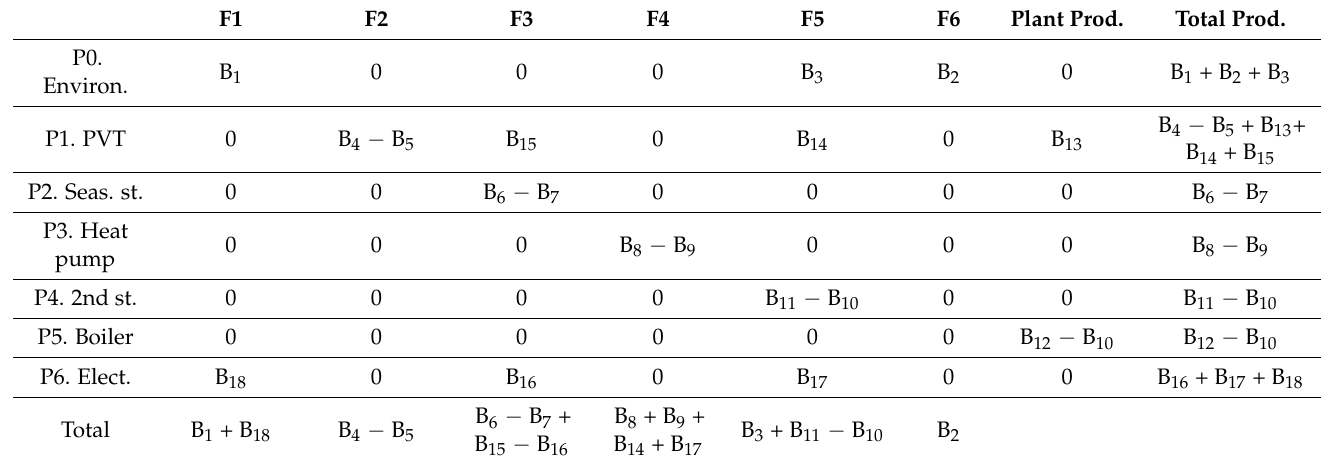
Table 2. Fuel–product